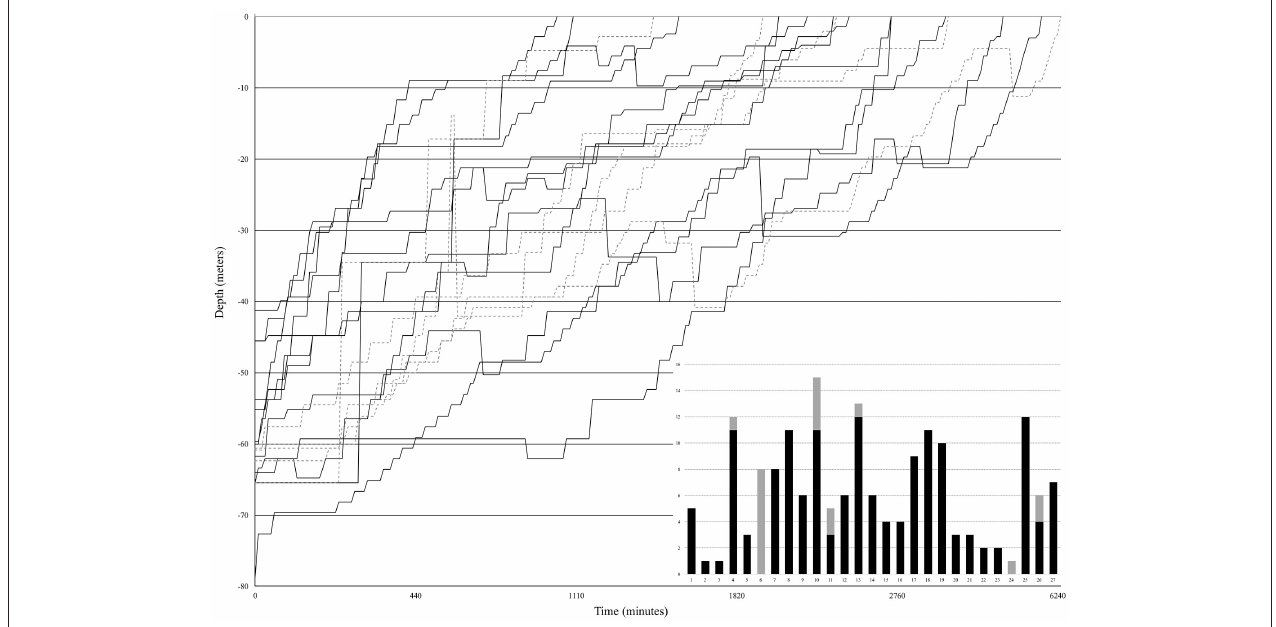
FIGURE 6 | Decompression profiles of 18 independent events on field expeditions to the Philippines, Vanuatu, Palau, and Pohnpei from 2014 through 2017. Black solid lines are decompression events with 100% survival ( n = 13). Gray dashed lines indicate decompression events where there was at least one mortality ( n = 5). The bar graph (inset) summarizes all 27 independent decompression events in this study. Stacked columns include all 174 fishes decompressed in our study. Black bars indicate success (100% survival, 20 of 27 events) and gray bars illustrate the 7 events where mortalities occurred during decompression.